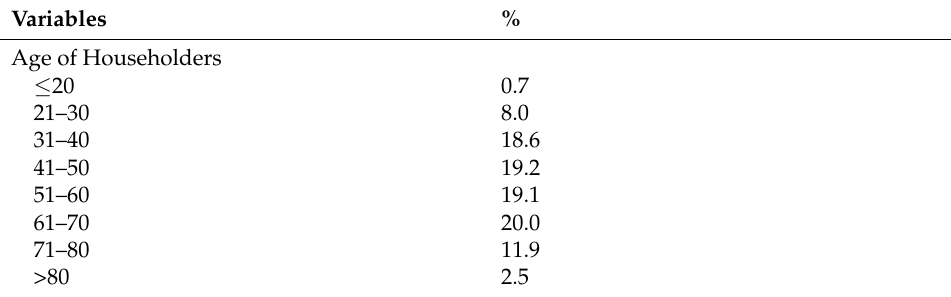
Table 3. Descriptive statistics of Household Pulse Survey